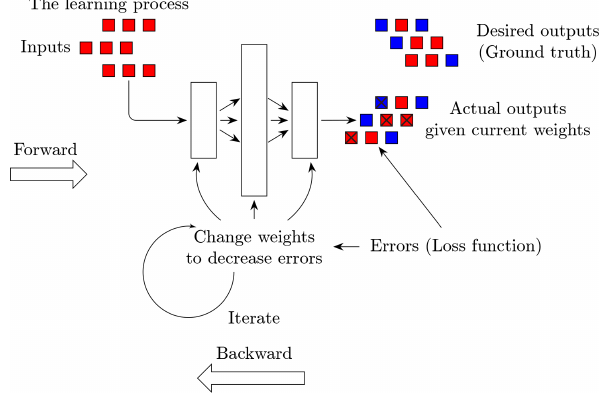
Figure 2. Learning process of a neural network (Stevens and Antiga,